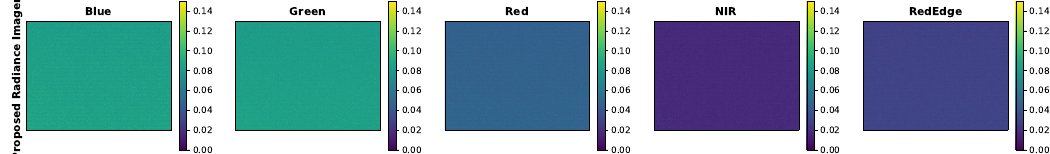
Figure 17. Example integrating sphere imagery converted into radiance using proposed technique. 3-D images are shown below for clarity.